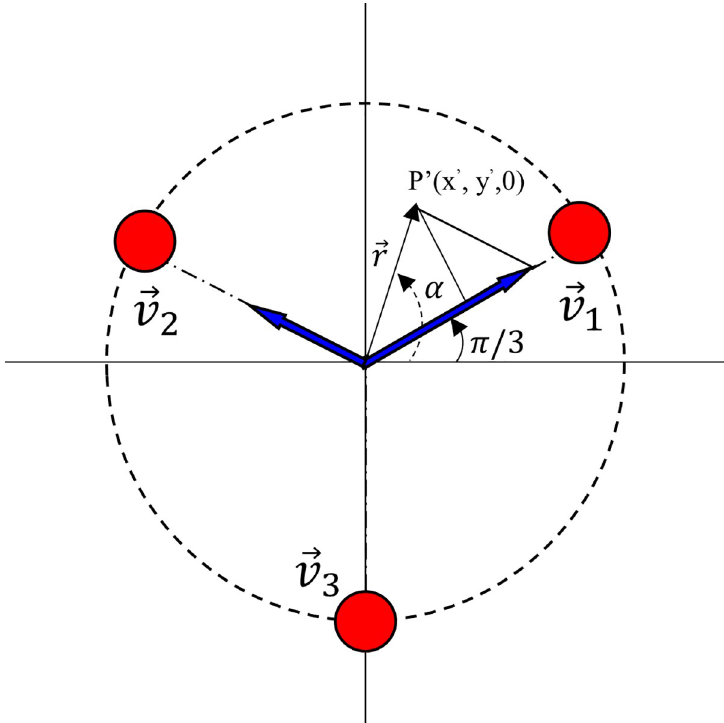
Fig 9. Scheme of the 3D coordinate of the projected vector r for the orientation of the Stewart